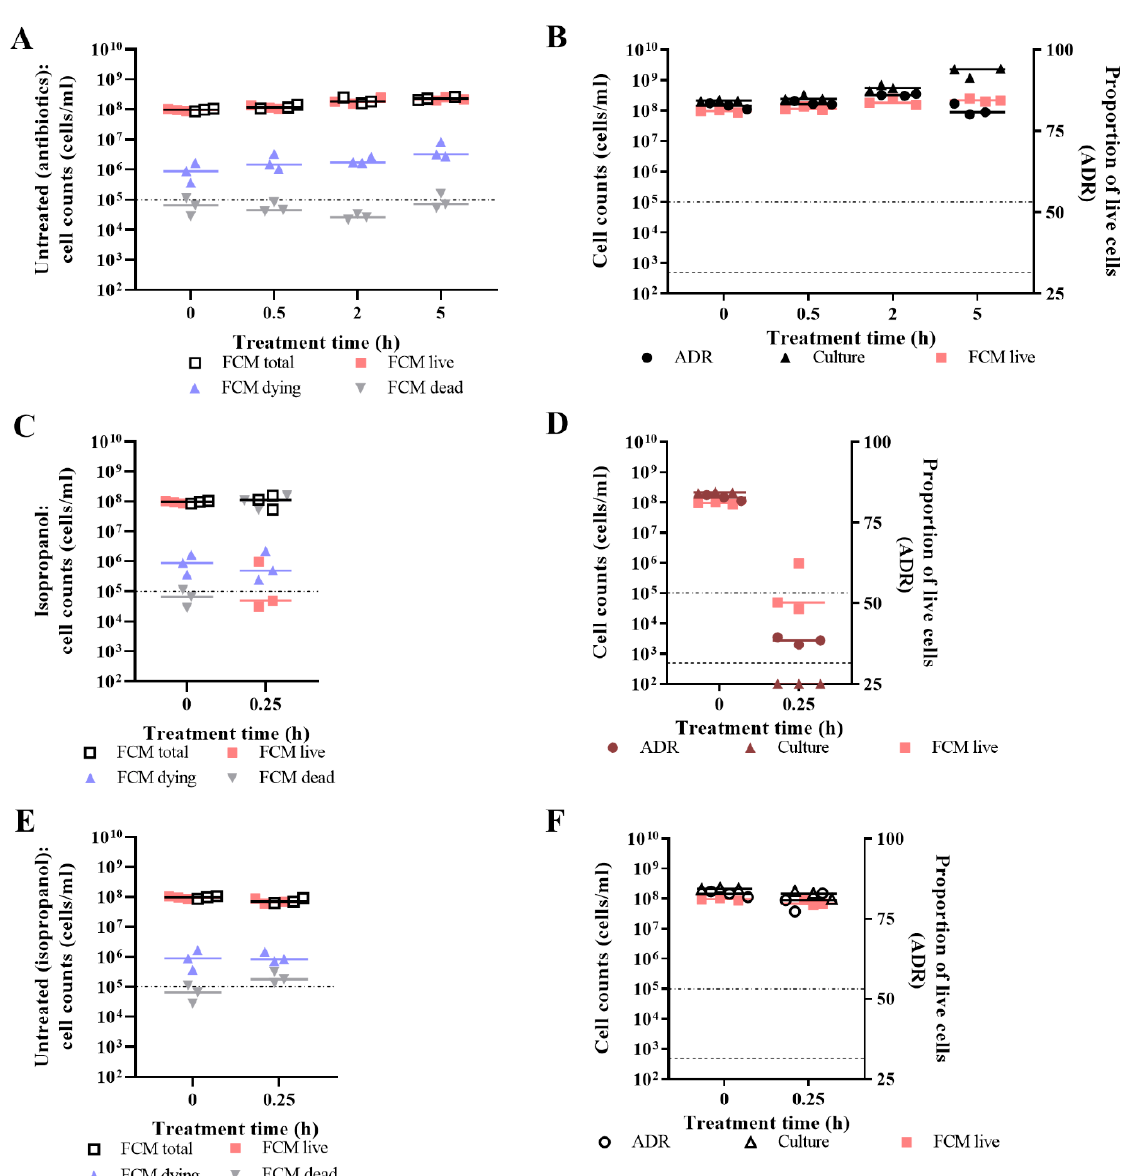
Figure 6. Flow cytometry of untreated E. coli and E. coli challenged with isopropanol. At 0 h and 0.25 h time points, viability of E. coli MG1655 challenged with 70% isopropanol ( C , D ) or nothing (untreated) at 37 ◦ C ( A , B ) and 28 ◦ C ( E , F ) was determined by measuring fluorescence of SYTO 9- and PI-stained cultures using the Optrode ( B , D , F ) and a LSR-II flow cytometer ( A , C , E ) and by culture-based enumeration ( B , D , F ). Measurements of untreated cells at 37 ◦ C were taken at 0 h, 0.5 h, 2 h, and 5 h time points to reflect the time points for antibiotic challenge, while for untreated cells at 28 ◦ C, measurements were taken at 0 h and 0.25 h to reflect the isopropanol challenge. FCM generated a total cell count, live cell count, dying cell count, and dead cell count ( A , C , E ). The dot-dash line represents the limit of quantification for FCM (1 × 10 5 cells/mL). For Optrode measurements, fluorescence intensities were obtained from integrating 505–515 nm for green emissions and 600–610 nm for red emissions. The proportion of live cells in the sample population was determined by the adjusted dye ratio (ADR; B , D , F ). The limit of detection for culture-based enumeration is 500 CFU/mL (dashed line). Data presented is from three biological replicates with a line plotted at the